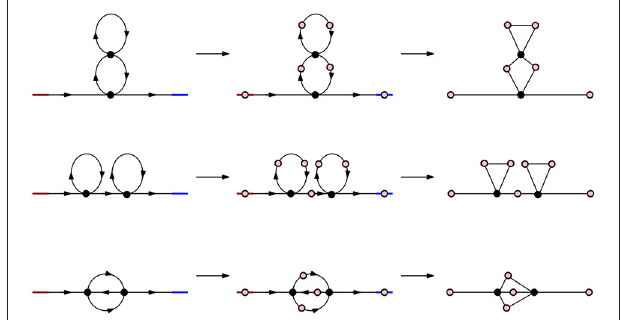
FIGURE 4 | Simplicial representations of molecules with parallel, series, and cross arrangement. In all three cases the corresponding Betti numbers are: β 0 = 1 ,β 1 = 2 ,β n = 0 for n ≥ 2